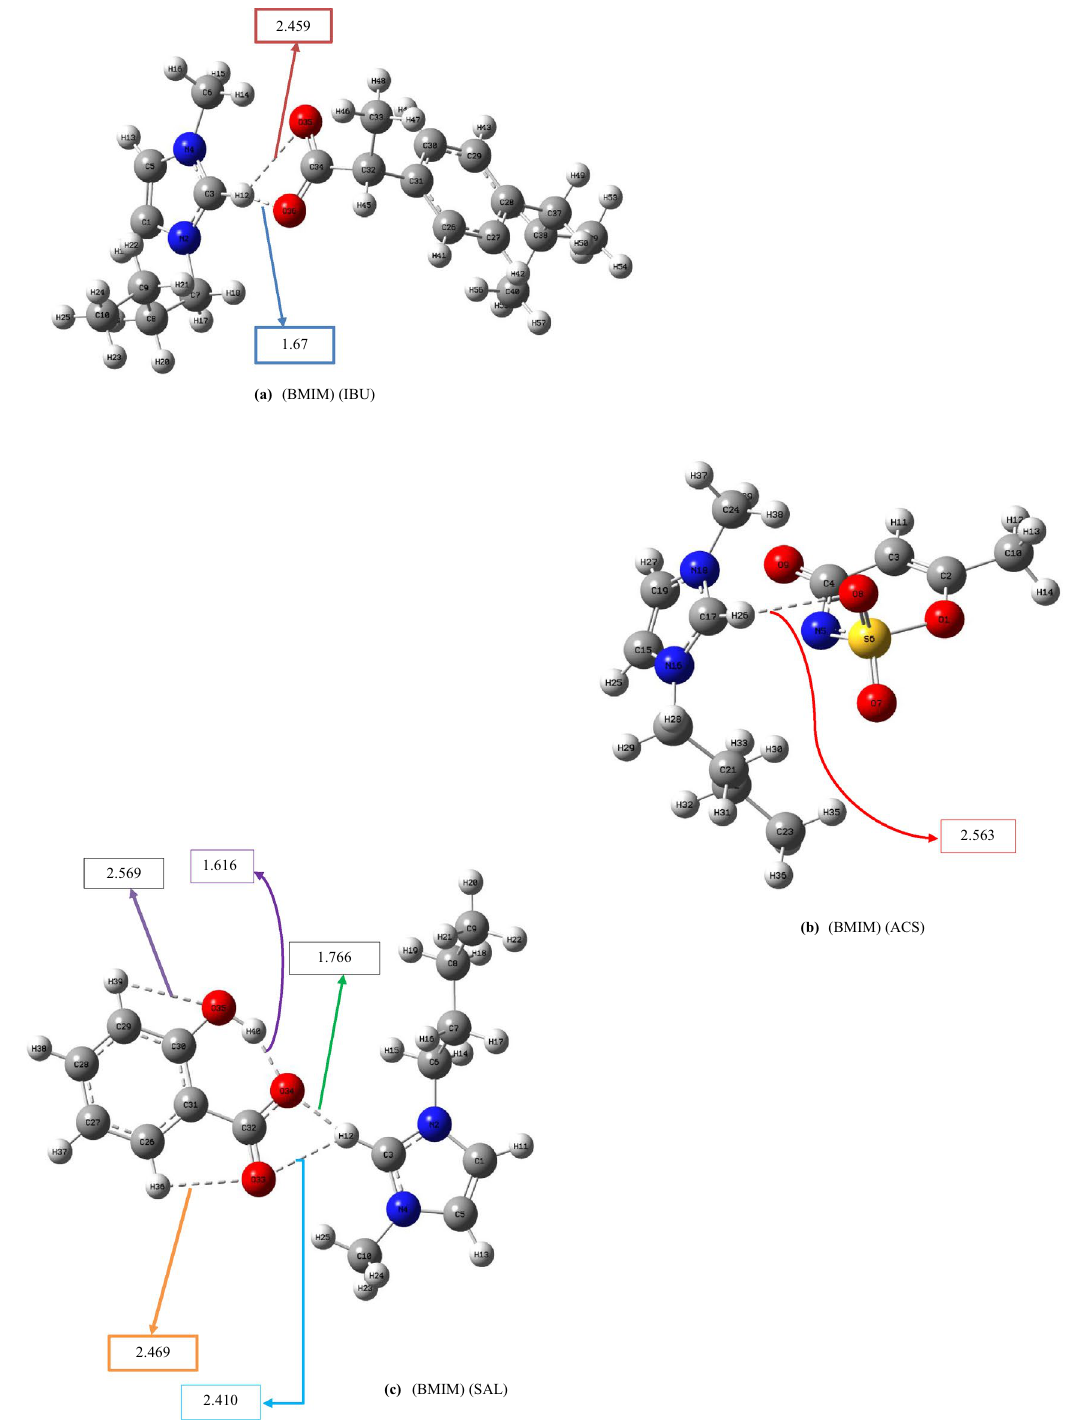
Figure 1. Optimized geometries of the lowest-energy conformers of BMIM-based pharmaceautically active ILs calculated at the B3LYP/6-311++G(d,p)